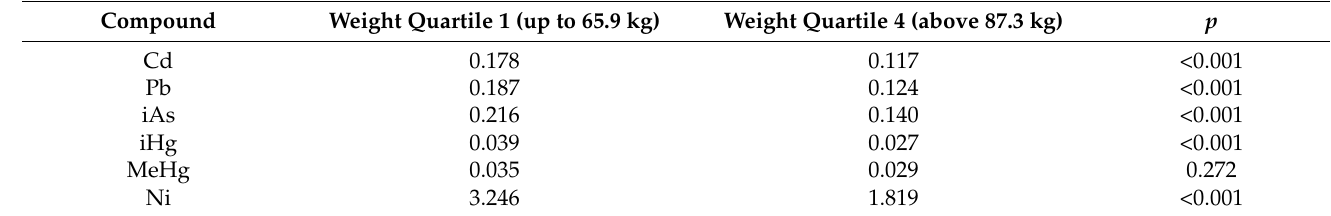
Table 6. Statistical comparison of mean exposure (in µ g/kg bw/d) of lowest and highest weight quartile among the whole population group studied in FinDiet 2012 (25 to 74 years, both genders). Independent samples t -test was used, and equal variances were not